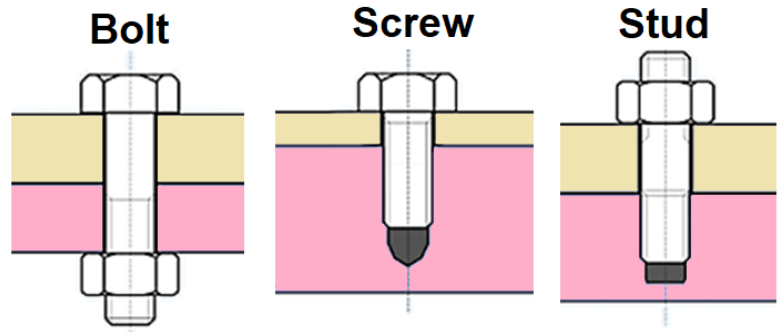
Figure 6. Schematic of common types of fasteners.